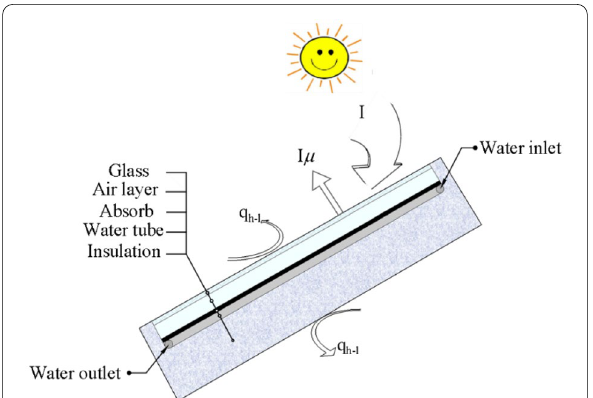
Fig. 1 Schematic of collector’s working principle